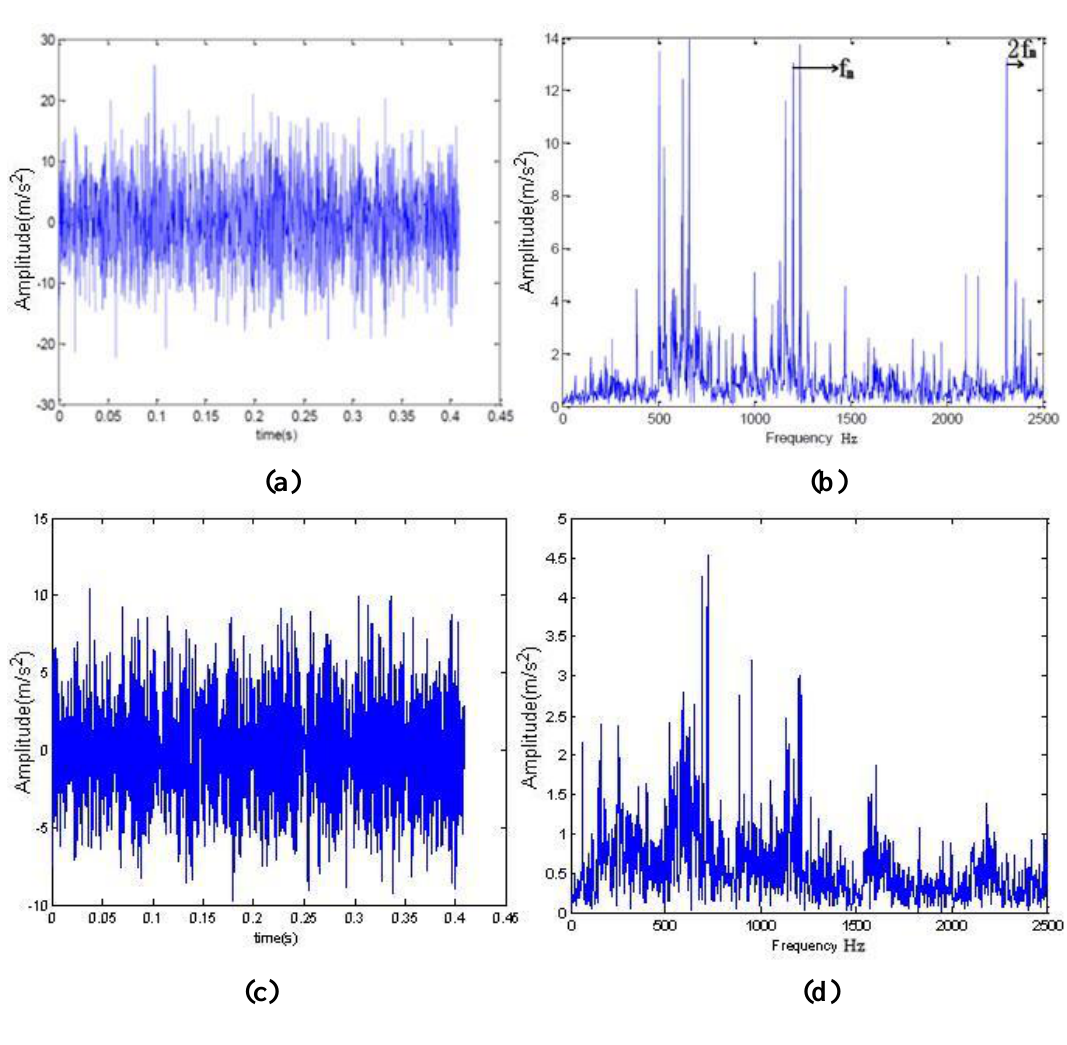
Figure 4. Comparison between waveform and spectrum with fault or